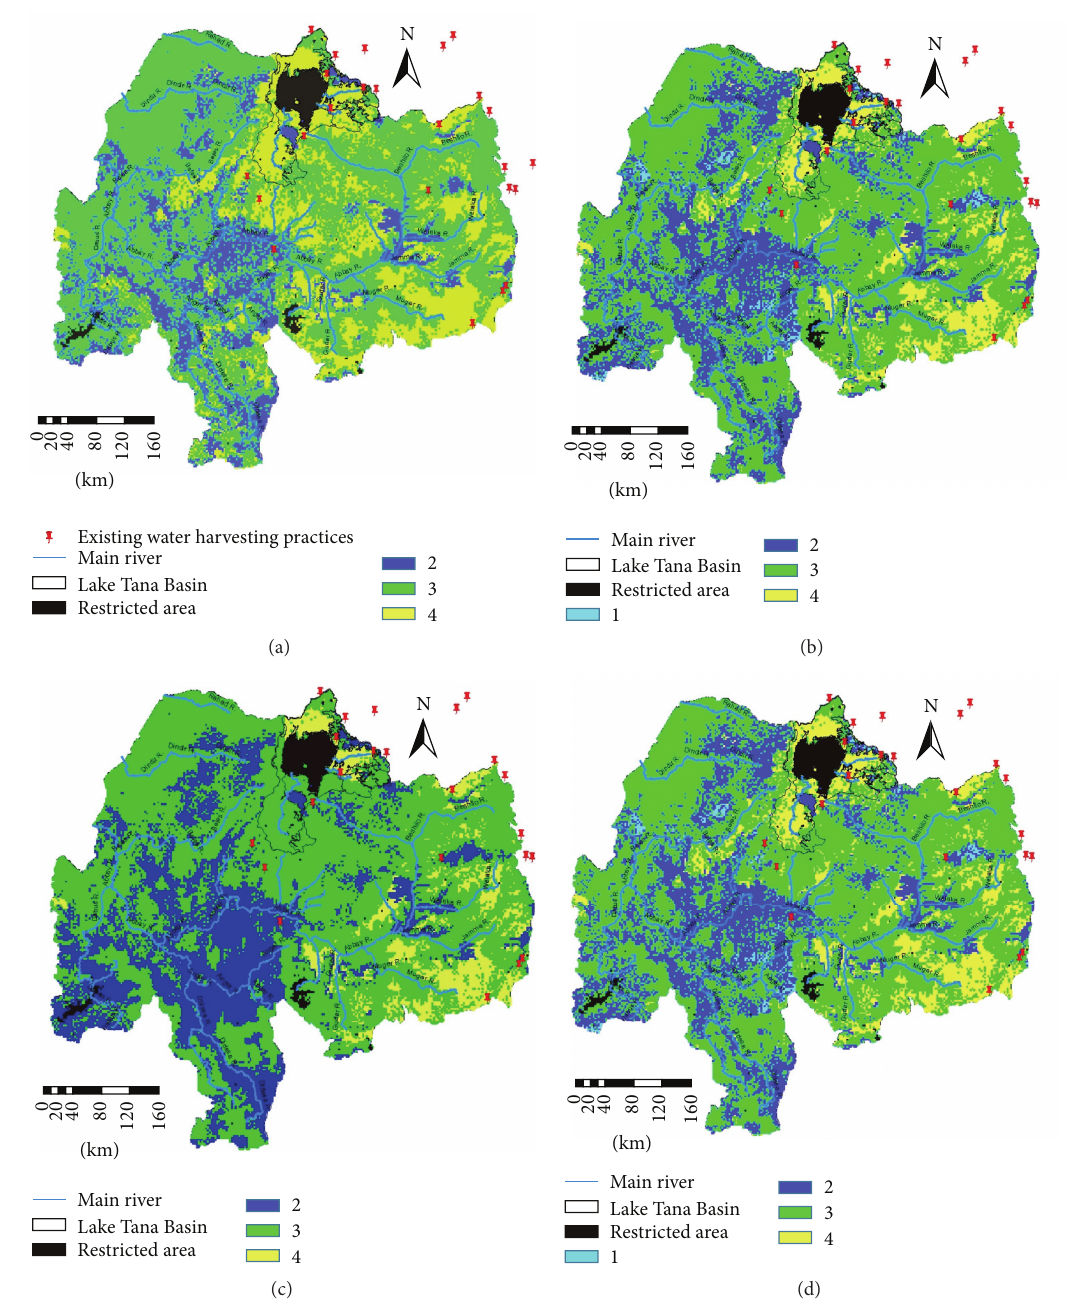
Figure 4: Suitability of the Upper Blue Nile Basin for water harvesting under: (a) equal percentage influence of factors considered; (b) percentage influence of 30, 30, 20, and 20 for rainfall, slope, land cover, and soil, respectively; (c) percentage influence of 35, 25, 20, and 20 for rainfall, slope, land cover, and soil, respectively; and (d) percentage influence of 25, 35, 20, and 20 for rainfall, slope, land cover, and soil, respectively (4: highly suitable, 3: moderately suitable, and 1-2: less